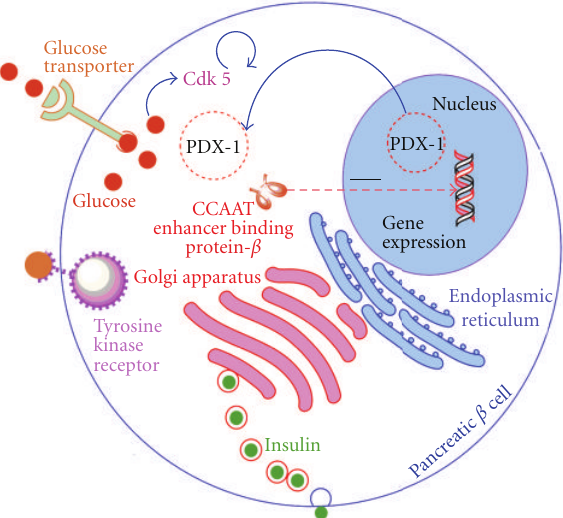
Figure 2: Regulation of insulin secretion by CDK5: cyclin- dependent kinase 5 (CDK5) prevents the secretion of insulin by phosphorylating the loop II and loop III of α 1c subunit of L-type voltage-dependent calcium channels (L-VDCCs) so that calcium could not find the entry into the pancreatic β cell as the L-VDCC channel activity is deterred due to the phosphorylation leading to the decreased concentration of cytosolic Ca 2+ .